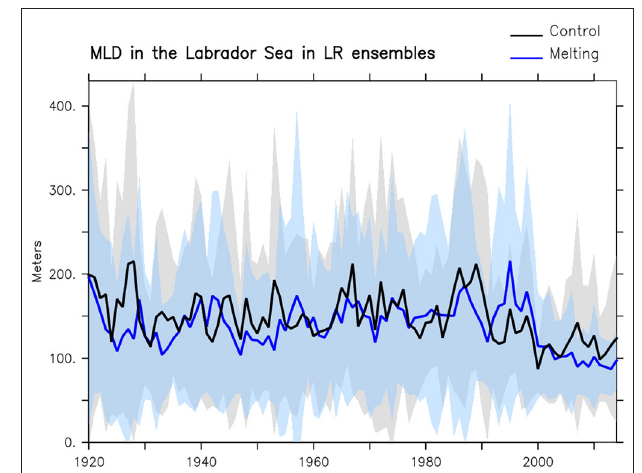
FIGURE 7 | Evolution of the MLD (in meters) in the Labrador Sea convection site (defined in Figure 3 ) from the two 20-member LR ensembles averaged in January–February–March. In black is the ensemble of the control simulations and in blue, the ensemble of the melting simulations. The overlaps represent two standard deviations computed from the 20